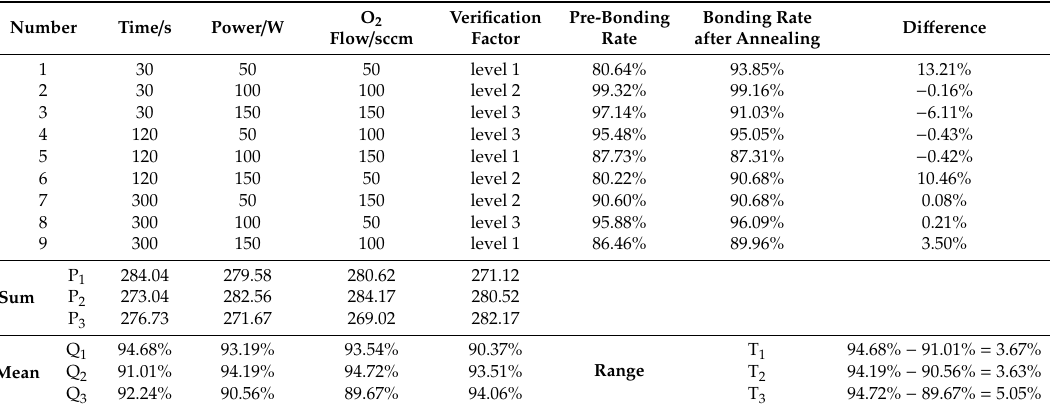
Table 4. L9 (3 4 ) orthogonal experiment data